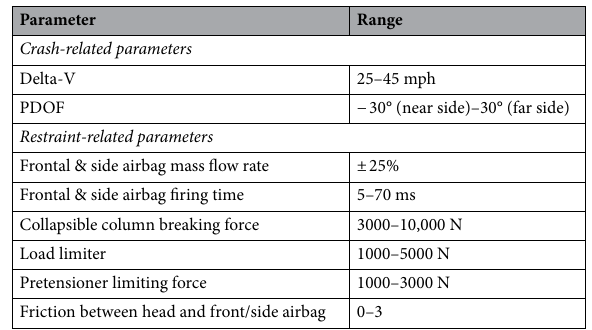
Table 1. Parameters and their ranges.